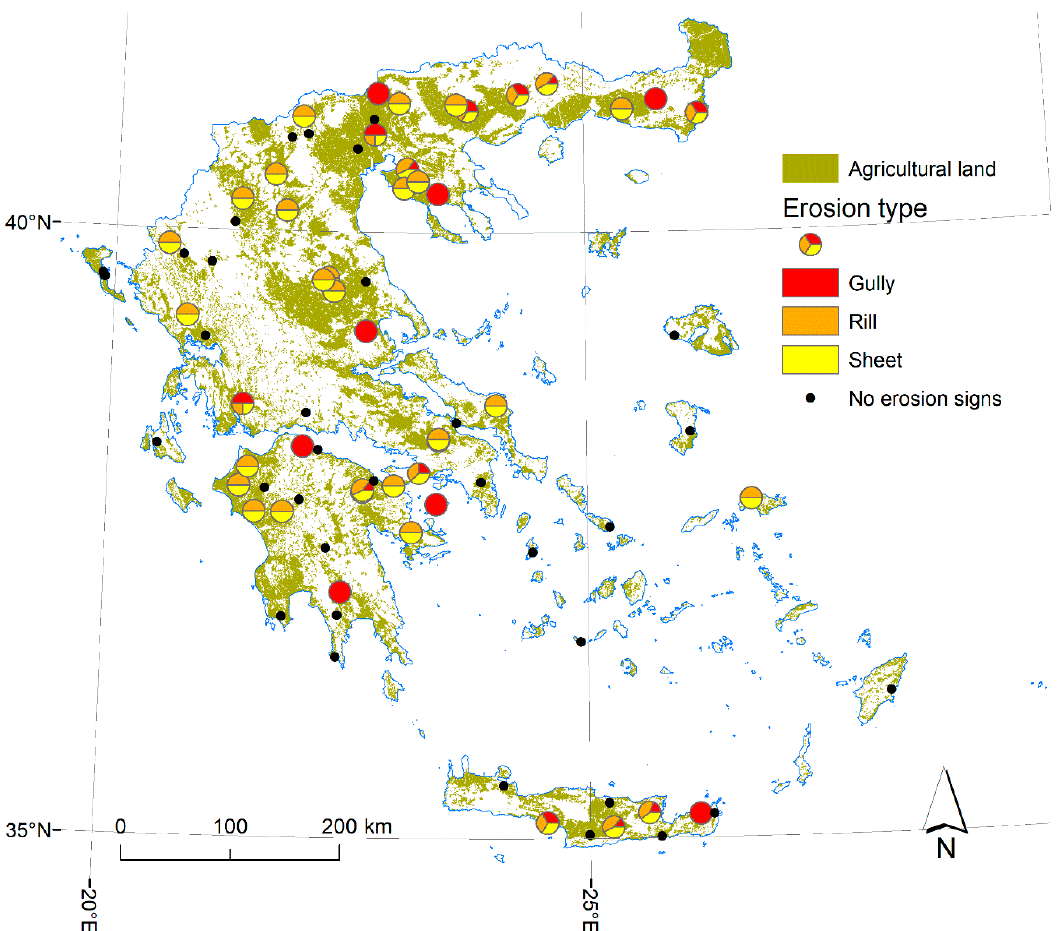
Figure 4. Relative proportion of gullies, rills, and sheet erosion in the randomly sampled surfaces; five categories of severity were considered for gullies, and three for rills and sheet erosion.